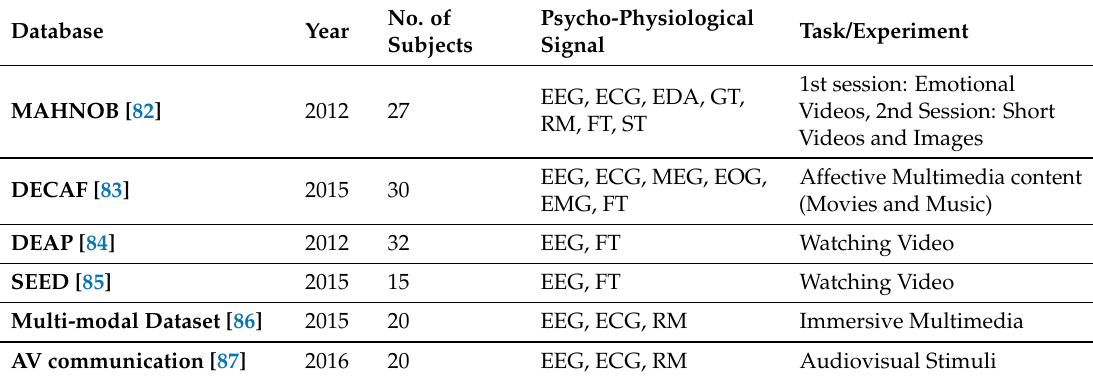
Table 3. Summary of Publicly available datasets for emotion recognition (EDA: Electrodermal activity, GT: Gaze tracking, MEG: Magnetoencephalogram, EOG: Electrooculogram, EMG: Electromyography, RM: Respiration measurement, FT: Facial Tracking, ST: Skin